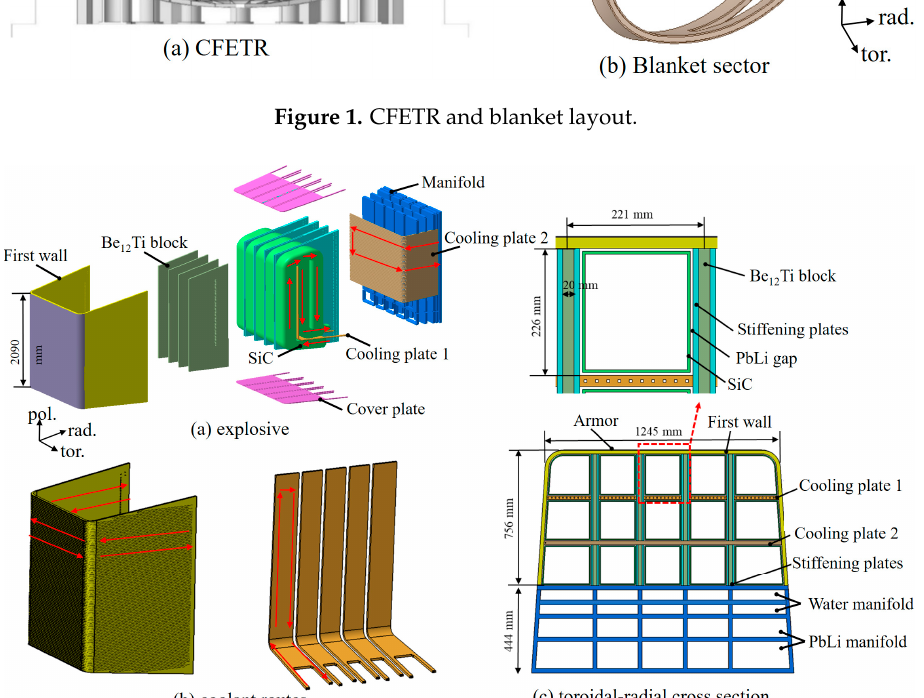
Energies 2021 , 14 , 6350